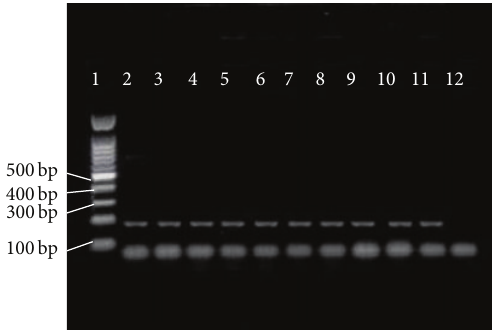
Figure 7: PCR results of ecbA . 1 = marker = 100bp; 2–11 = ecbA = 182 bp; 12 = negative control.